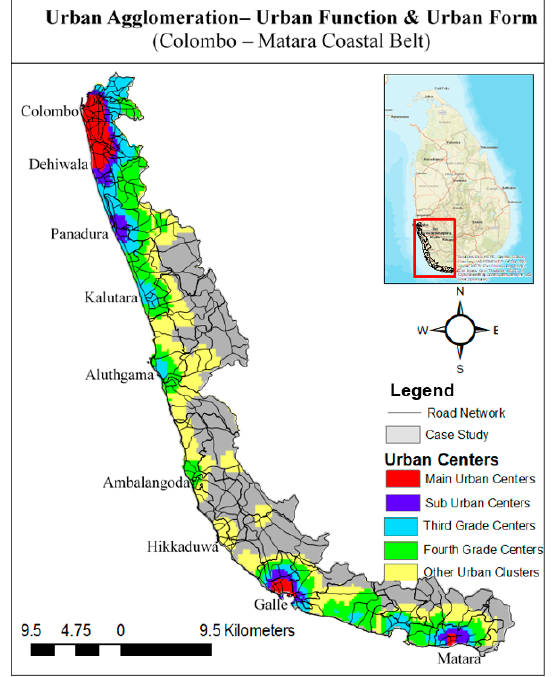
Figure 8. Composite map of all urban form and function-related parameters.